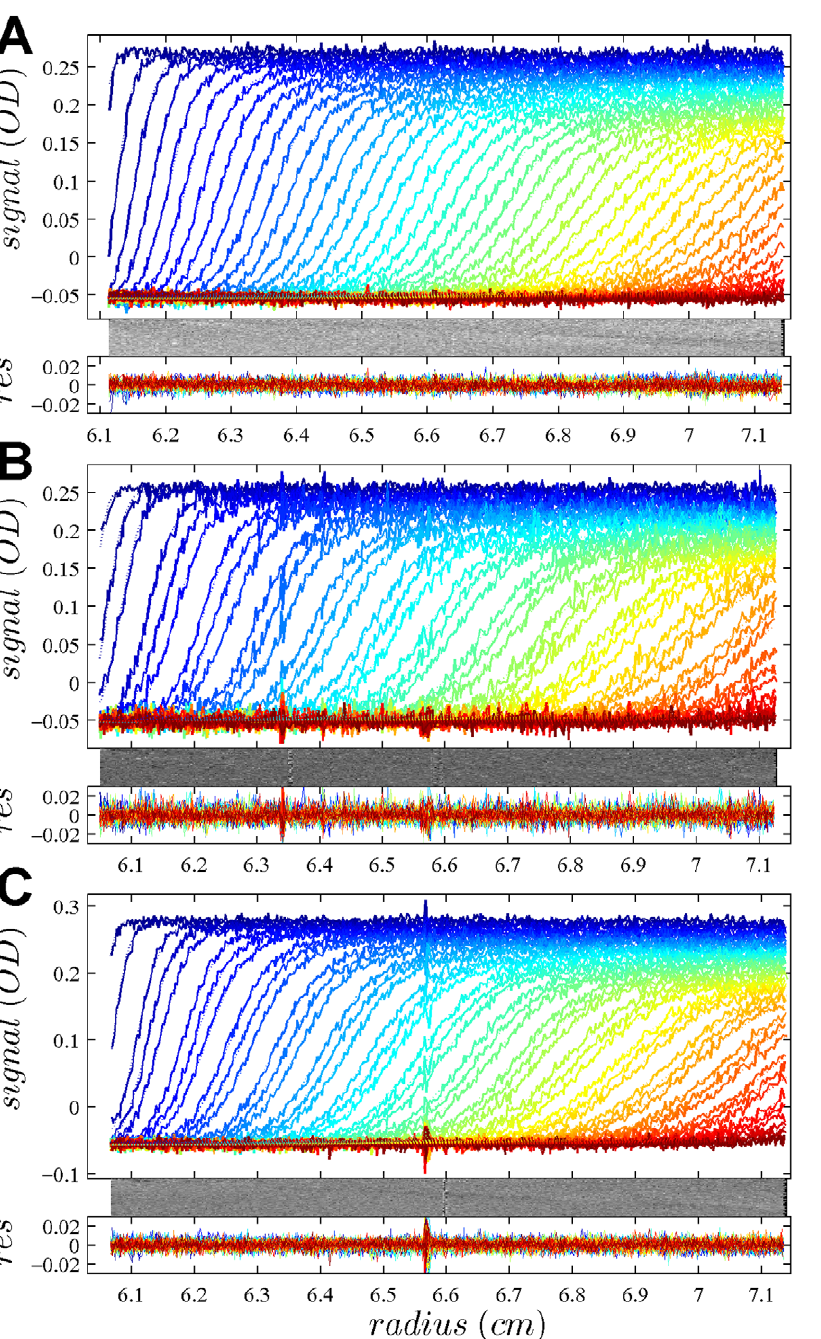
Figure 1. Global density variation SV analysis of the phosphorylase B sample recorded with the absorbance data at 280 nm. The sets of panels present the data in (A) H 2 O, (B) 50% H 218 O, and (C) 90% H 218 O based buffer. For each set of panels, the measured data (corrected for the time-invariant noise contributions) are shown as solid lines, and the global best-fit profiles are shown as thin dotted lines (virtually superimposed to the data). Higher color temperatures indicate later times. Below are the residuals bitmap (a 2d grey-scale representation of residual values with time plotted vertically and radius horizontally [69]) and the residuals of the fit, with rmsd of 0.00365 OD (A), 0.00411 OD (B), and 0.00380 (C). In the presence of H 218 O, fewer scans were included into the analysis in order to achieve similar numbers of total scans representing the sedimentation process. The best-fit c ( s ) distribution from this analysis is shown in Figure 2.